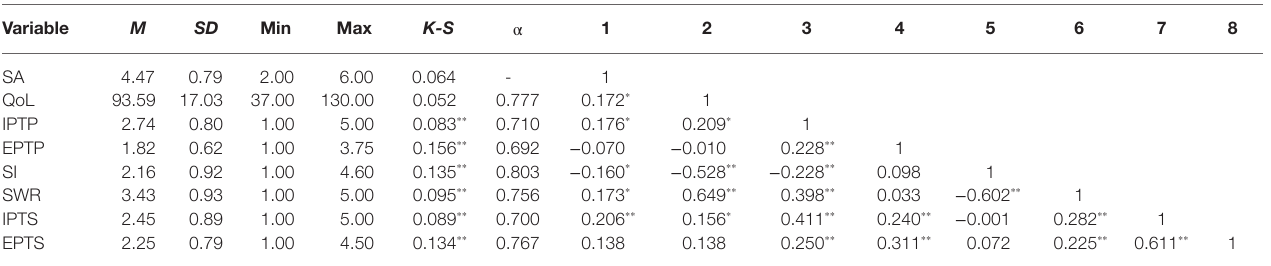
TABLE 1 | Summary statistics and correlations between study variables ( N = 191). Variable